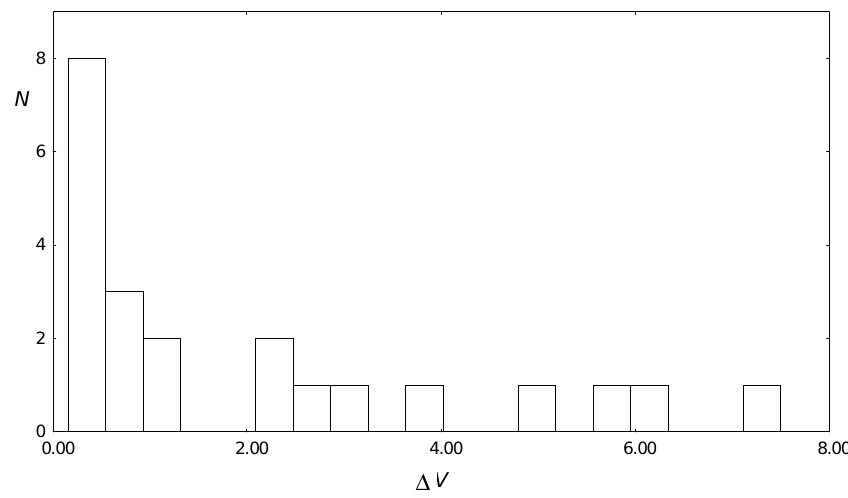
Fig. 2. The histogram of magnitude differences Δ V of the